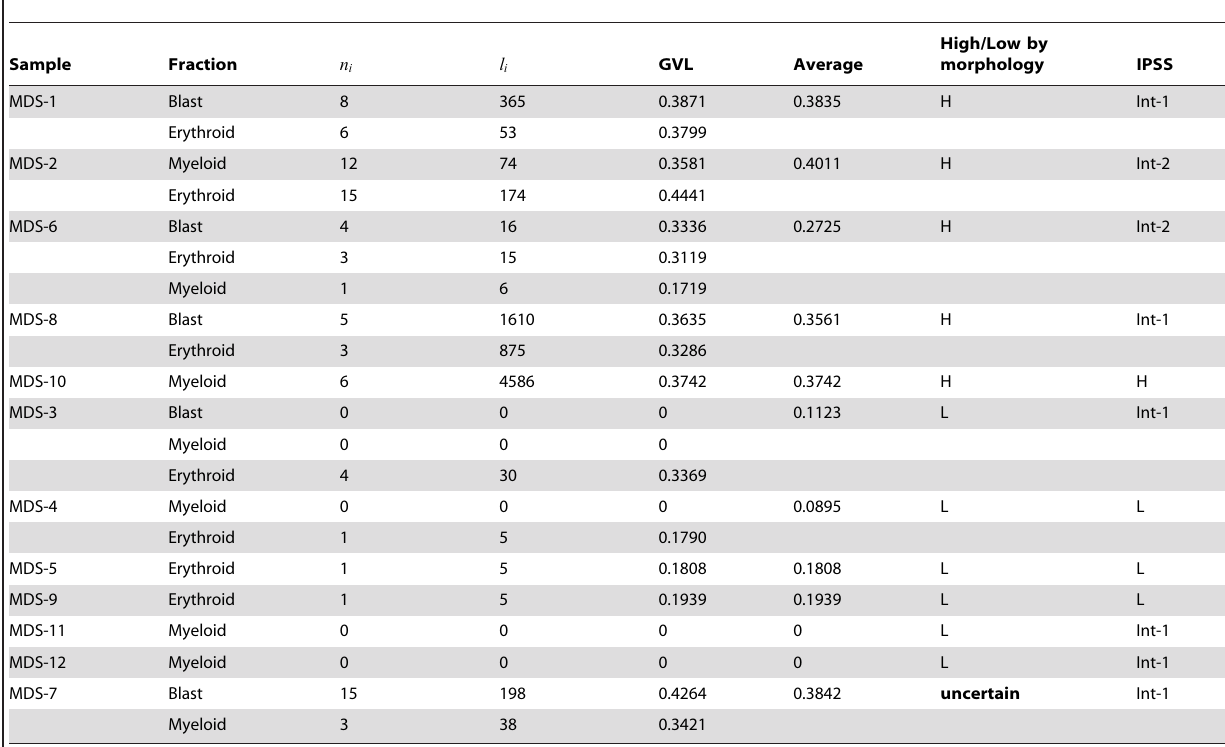
Table 4. The average GVL of MDS patients and the discrimination between the high grade MDS and the low grade MDS by both cell morphology and IPSS score.